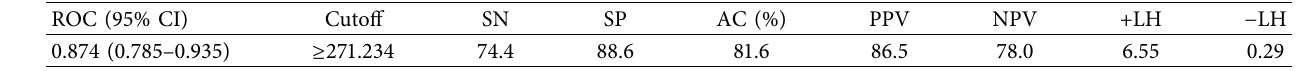
Table 3: ROC analysis of the validity of kisspeptin as a predictor of